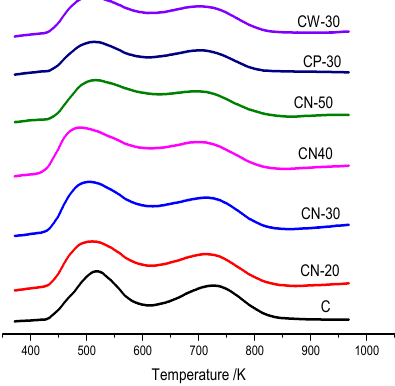
Figure 6. NH 3 -TPD spectra of the catalysts. Figure 6. NH 3 ‐ TPD spectra of the catalysts.